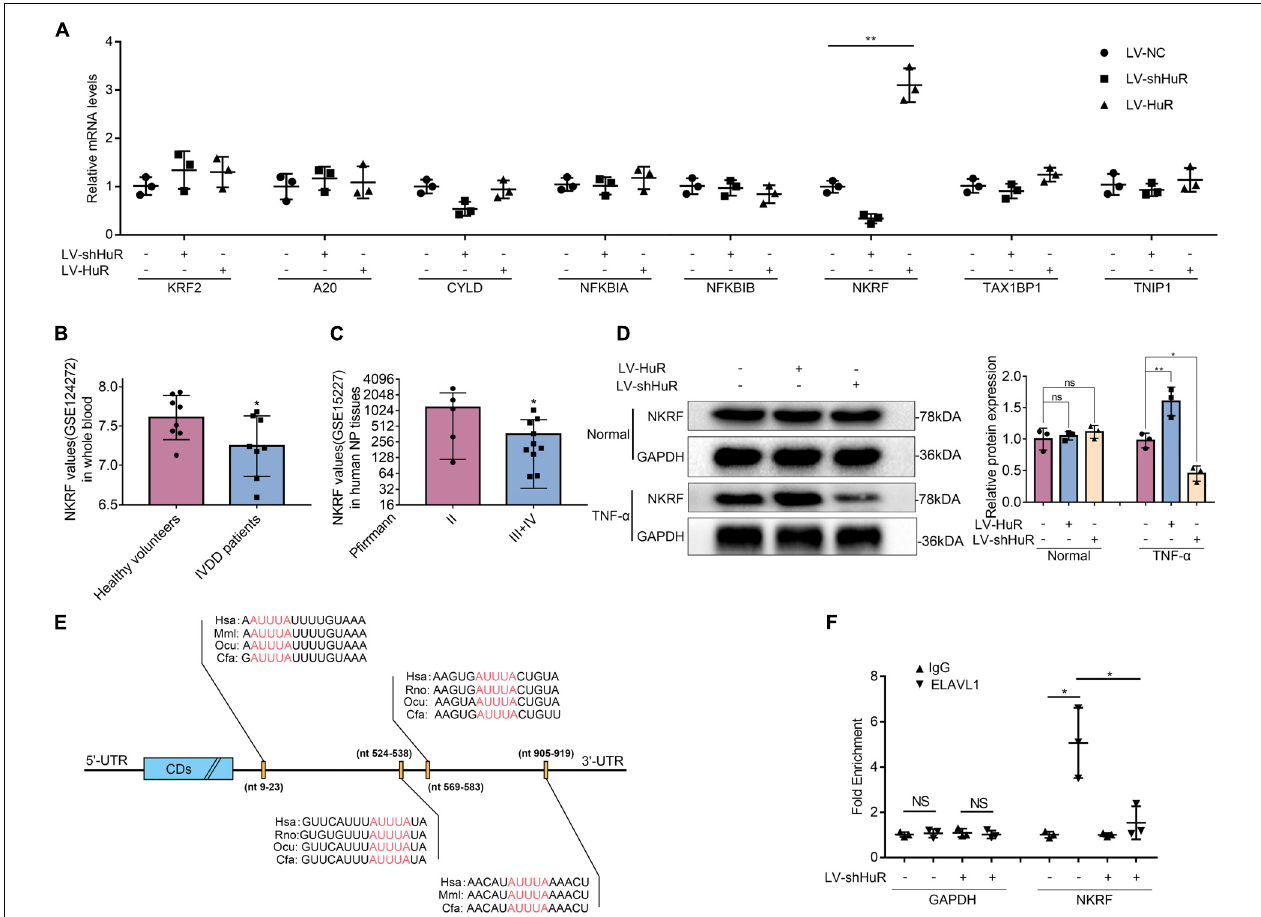
FIGURE 4 | HuR regulates NF- κ B signaling pathway through NKRF in TNF- α -treated NP cells. The cells were transfected with LV-shHuR or LV-HuR before TNF- α treatment. (A) The known proteins that inhibit NF- κ B activation were listed, and the multiple mRNA expressions were detected by qPCR after TNF- α treatment. (B) The NKRF gene expression from GSE124272 in human whole blood. (C) The NKRF gene expression from GSE15227 in human degenerated NP tissues. (D) The protein expression of NKRF was detected by Western blot, treated with or without TNF- α treatment; the levels were determined using Image J software. (E) The potential HuR-binding element in 3 (cid:48) UTR of NKRF mRNA on multiple species. (F) The mRNA expression of NKRF was detected by qPCR after RIP in rat NP cells, normalized to IgG isotype controls. All data were shown as mean ± SD ( n = 3) * p < 0.05, ** p <